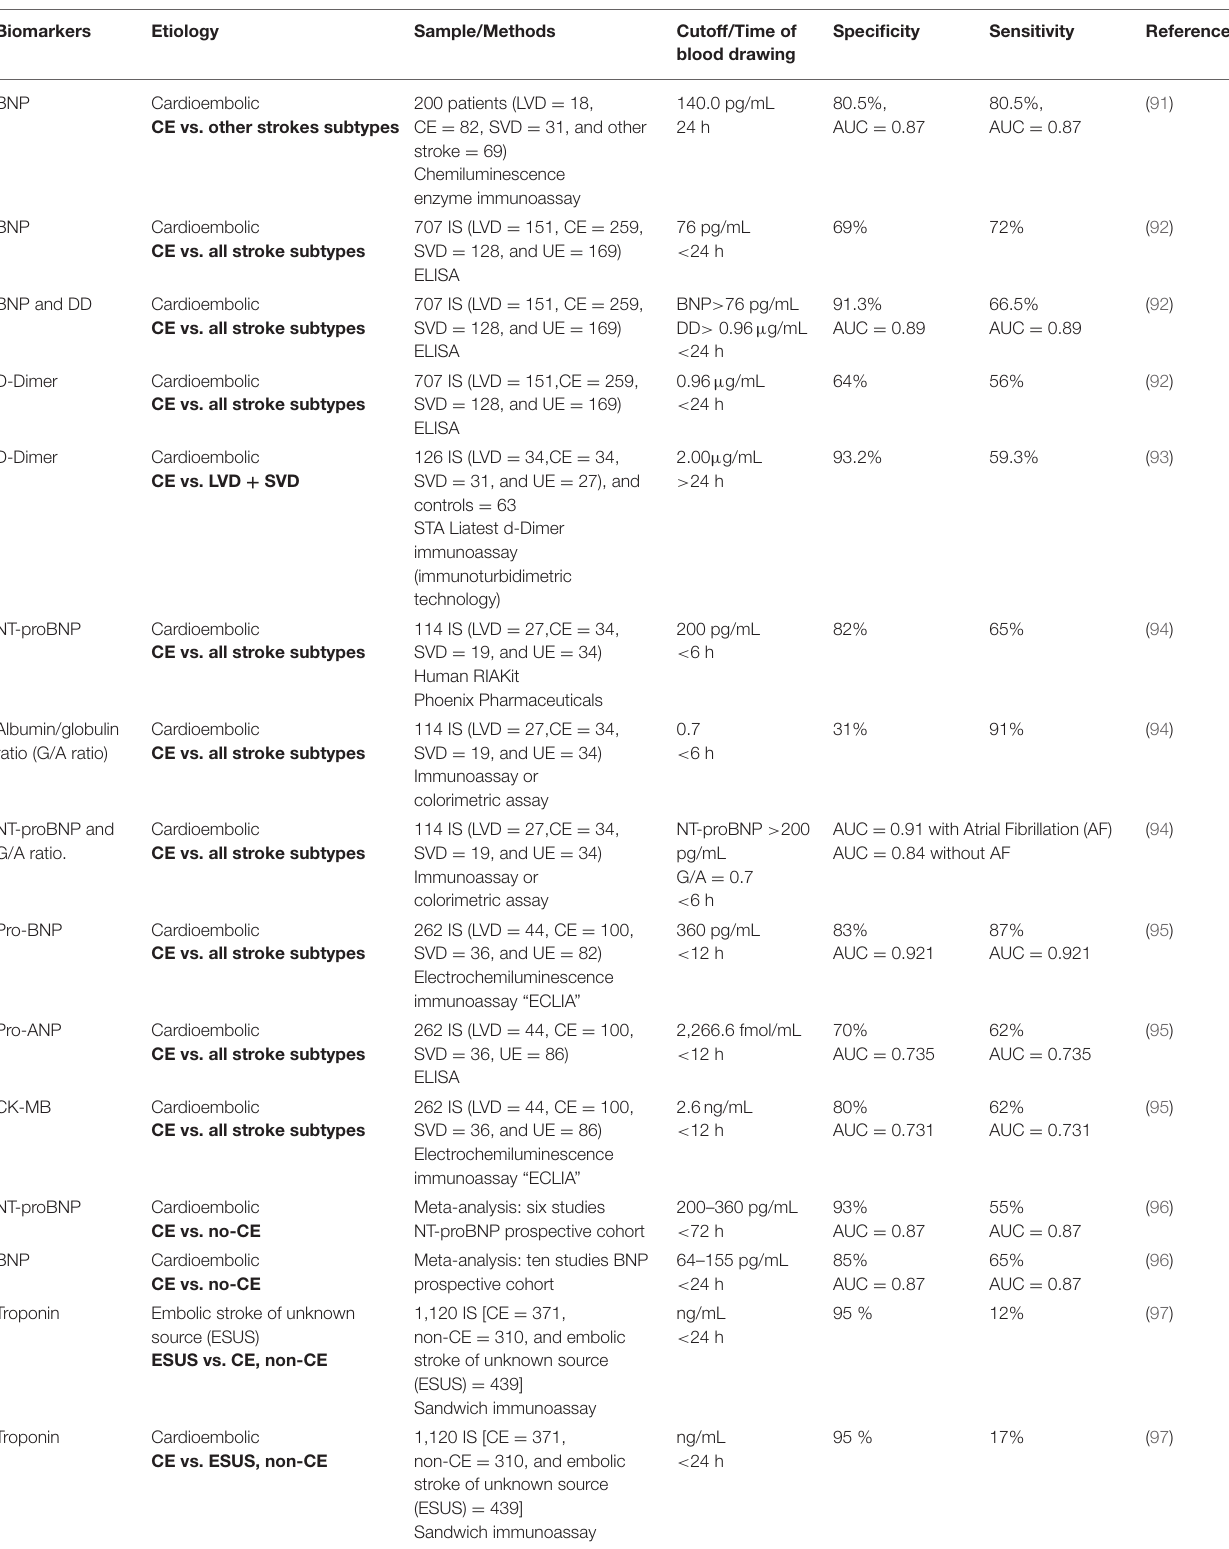
TABLE 4 | Summary of the biomarkers for the determination of the subtypes of stroke.